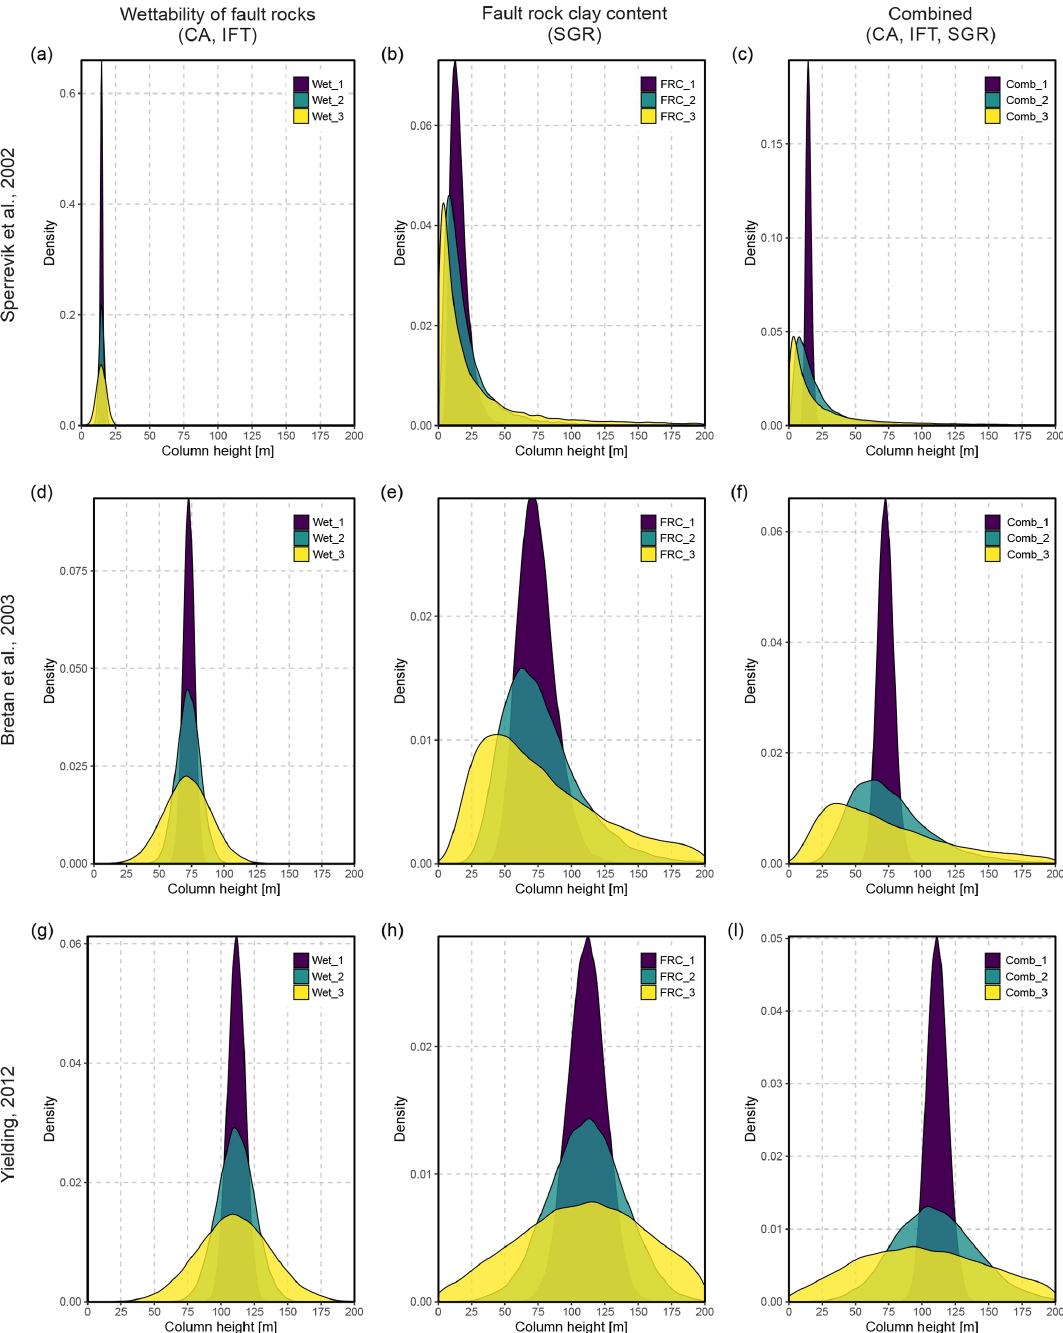
Figure 5. Density distribution of column heights of models for reservoir A (models 1 to 27). (a, d, g) The impact of uncertainties in fault rock wettability, (b, e, h) the impact of uncertainties in fault rock clay content (SGR), and (c, f, i) the impact of combined uncertainties on column heights. Each row uses a different approach to link fault rock composition to threshold pressure. Uncertainty increases from dark- to light-coloured models (Table 1). For all models N =